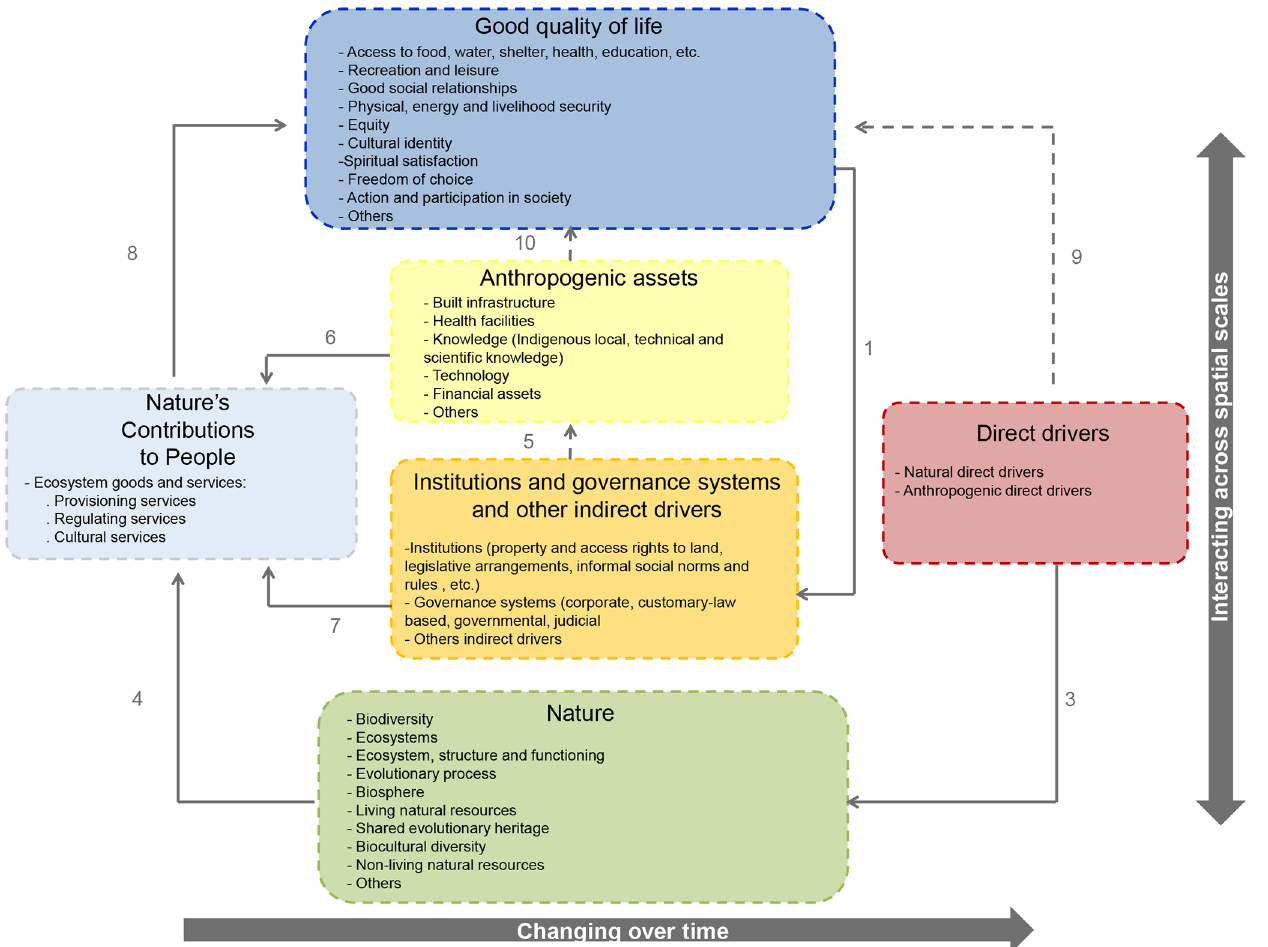
Figure A1. The IPBES framework guiding this research (reproduced from Díaz et al., 2015). Boxes denote six components (nature, nature’s contributions to people, anthropogenic assets, institutions and governance systems and other indirect drivers of change, direct drivers of change and good quality of life) and categories within each one. Arrows from 1 to 10 represent the linkages among the six components across different temporal and spatial